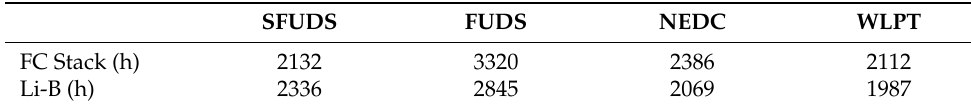
Table 10. Comparison of expected lifetime (Psplit2: δ = 1).